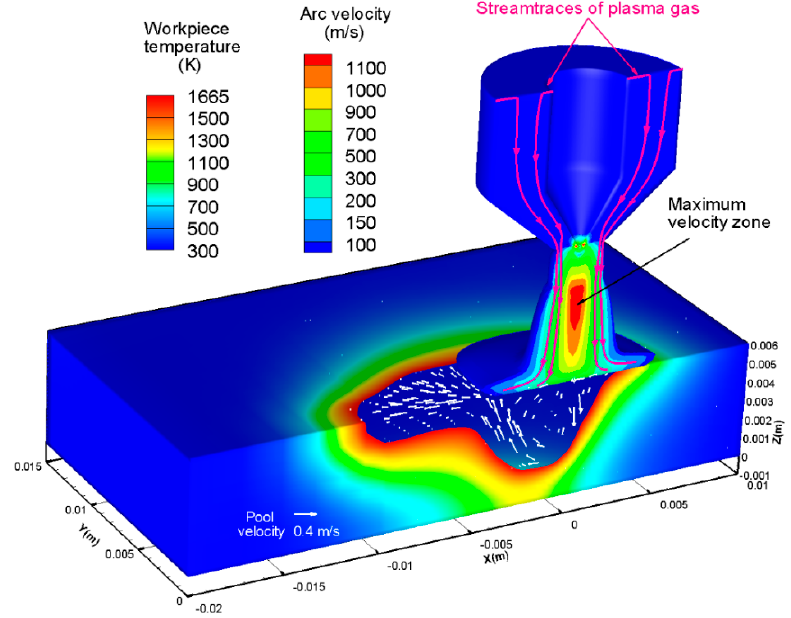
Figure 7. Flow distribution in the arc and weld pool.